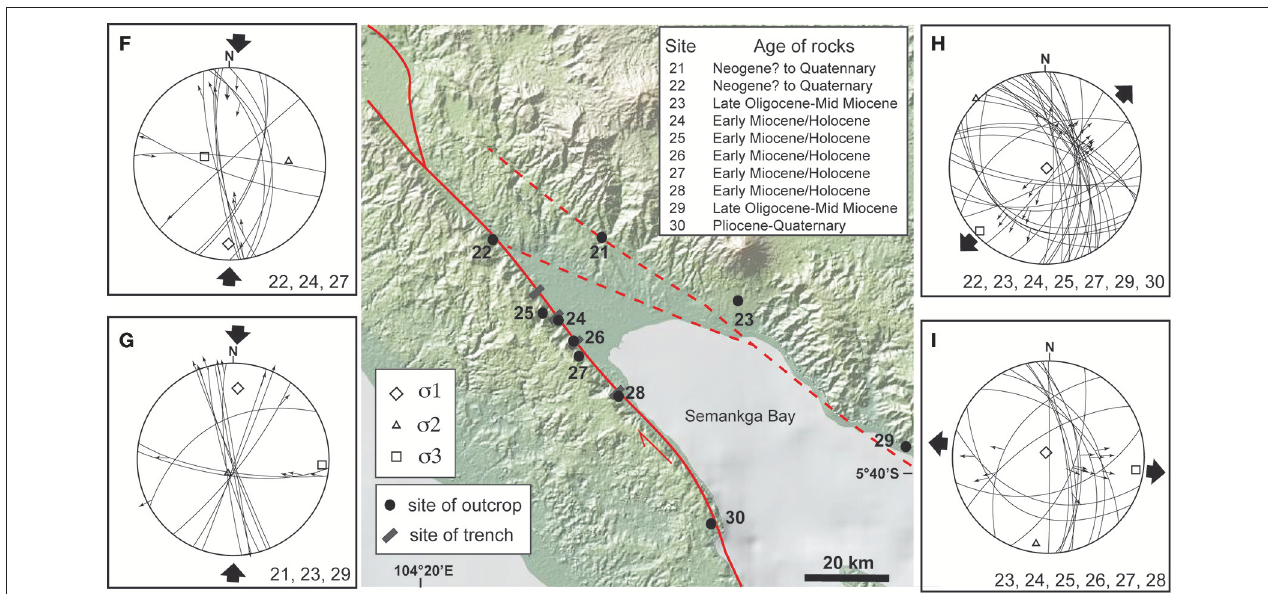
FIGURE 10 | Overview of the collected structural field data, along the southern portion of the GSF, on lower hemisphere stereograms of fault slip data together with the inversion results characterizing stress regimes. Numbers at bottom right of stereograms refer to the sites where the structural data have been measured (location in the map). Letters at upper left of stereograms (from F to I ) are used as reference in the text. The used inversion method (e.g., Carey, 1979) assumes that the slip represented by the striation occurs in the direction of the resolved shear. Deviatoric principal stress axes: σ 1 , σ 2 , σ 3 , are the compressional, intermediate and extensional deviatoric axes, respectively. The age of the faulted formation is also